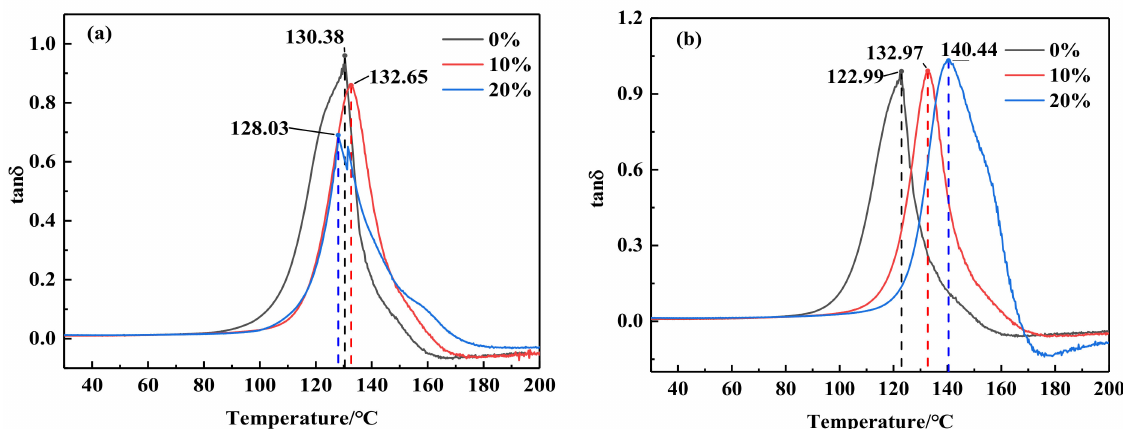
Figure 7. Loss factor − temperature spectrum of each resin system under different aging conditions ( a ) Loss factor without aging ( b ) Loss factor after 28 d salt